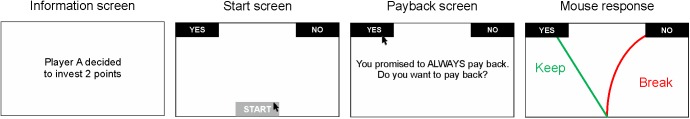
Depicted is one payback trial of the Promise Decision task from the trustee’s perspective. Each payback trial started with an information screen that informed the trustee about the investor’s decision. In case that the investor invested the two MUs, a start screen appeared and the trustee had to press the “START” button. After clicking the “START” button, the trustee was reminded of his/her promise and was asked whether he/she wants to pay back half of the MUs. The trustee then had to decide whether he/she actually wants to pay back (“YES”) or not (“NO”) by moving the mouse toward and finally clicking on the corresponding decision option at the top of the decision screen. Each participant completed a total of 24 such payback trials that were played with different and anonymous investors.